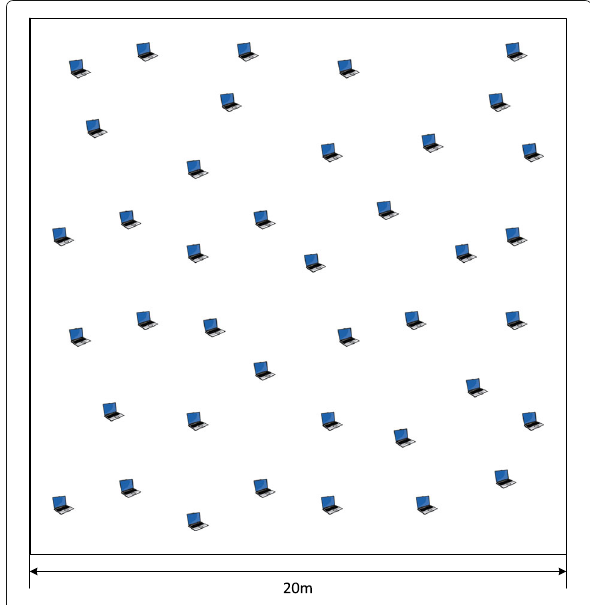
Fig. 15 An ad hoc network environment. Nodes are randomly placed in a 20 m × 20 m area. Half of the nodes are chosen as traffic senders, and each sender randomly selects a receiver to send UDP